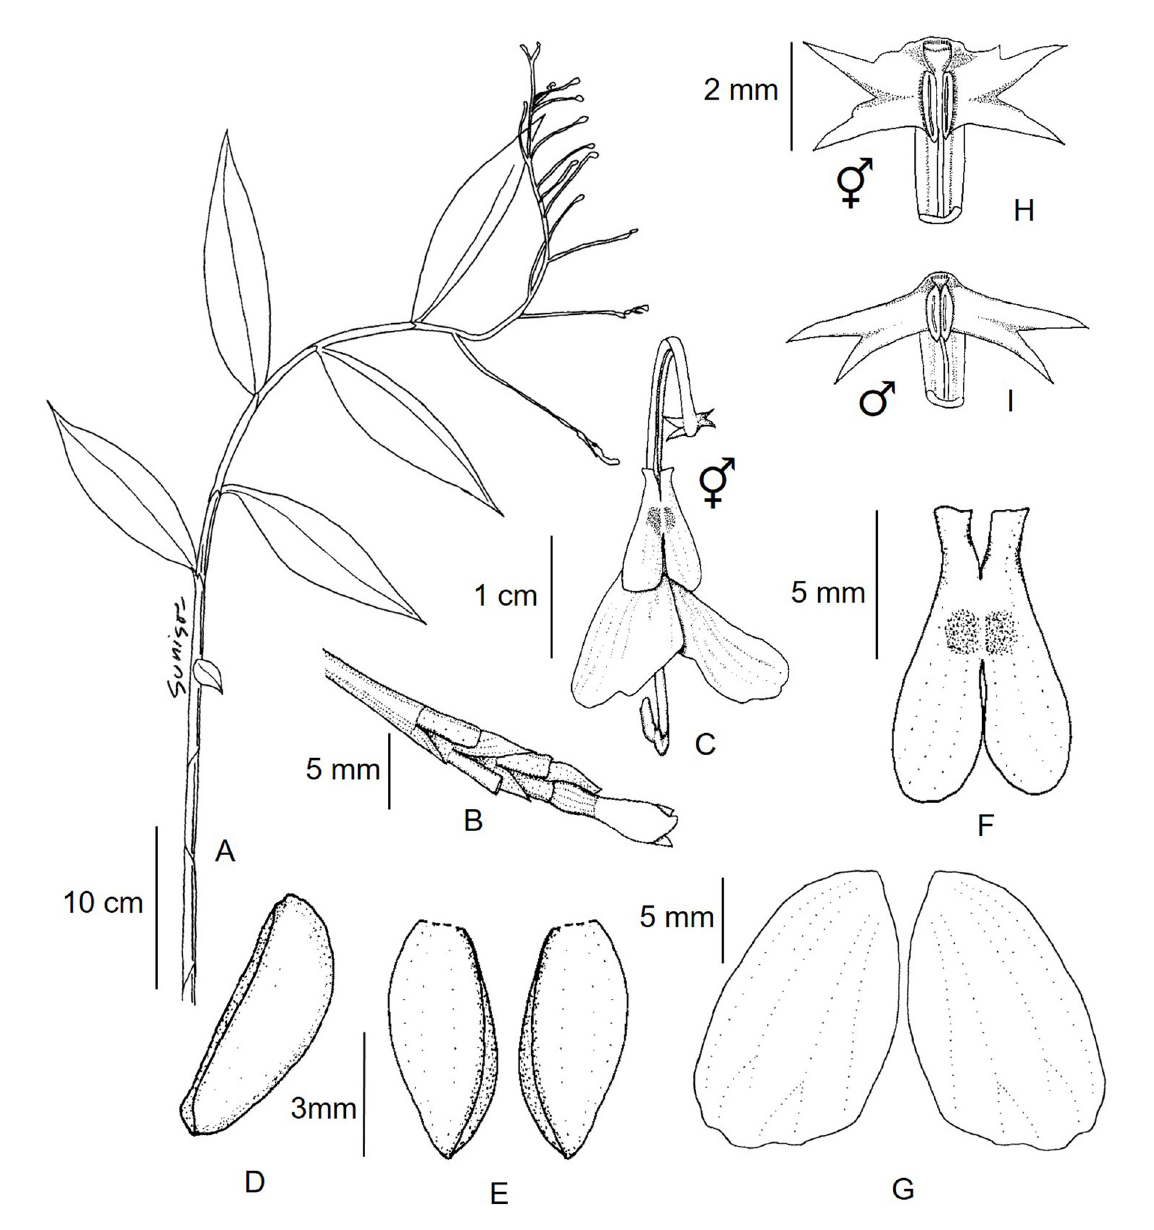
Fig. 4. Globba aranyaniae Sangvir. & M.F.Newman sp. nov. A . Habit. B . Tip of cincinnus. C . c flower. D . Dorsal corolla lobe. E . Lateral corolla lobes (same scale as D). F . Labellum. G . Lateral staminodes. H . c appendages. I . ♂ appendages (same scale as H). Drawing: S. Sangvirotjanapat from S. Sangvirotjanapat 785